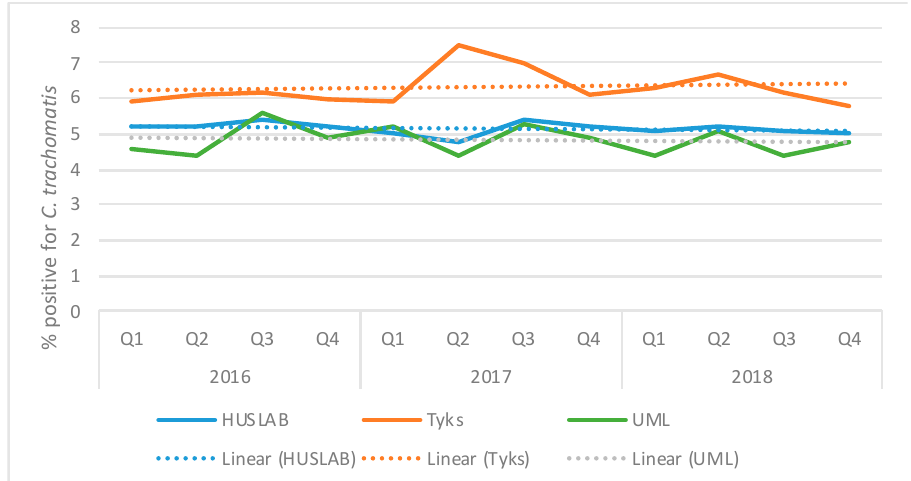
Figure 2. Quarterly proportions of Aptima Combo 2 specimens positive for C. trachomatis in three